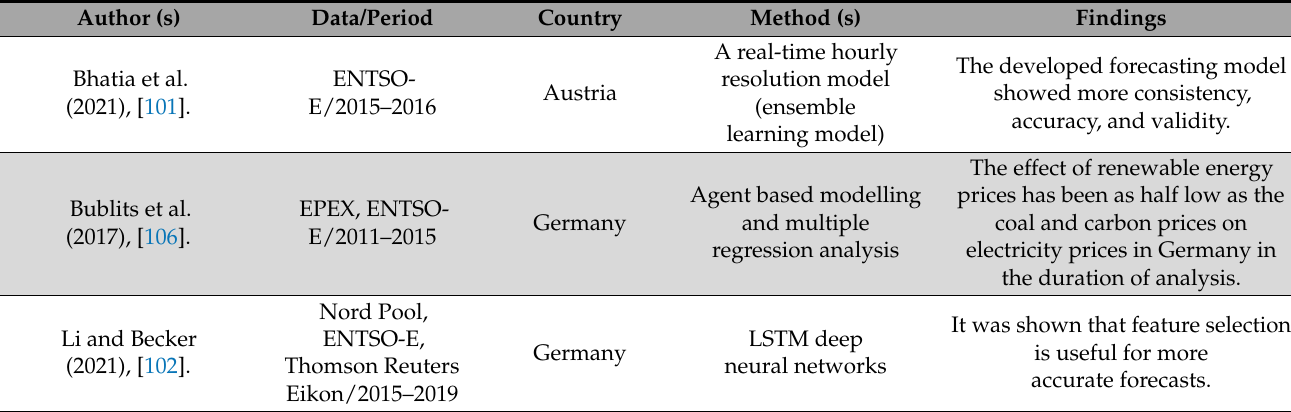
Table 4. A literature review through artificial intelligence and hybrid/ensemble models on electricity market price and load forecasting through wind